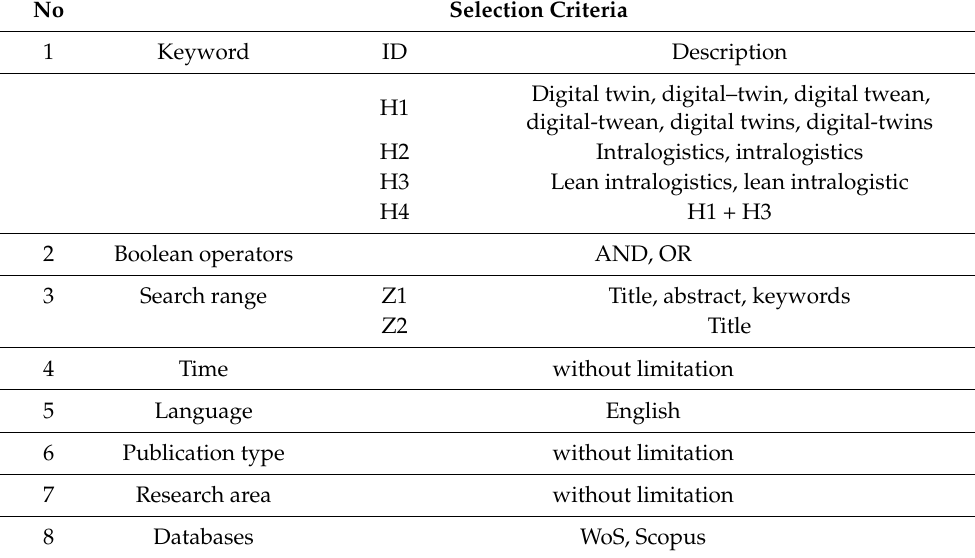
Table 1. Selection criteria definition